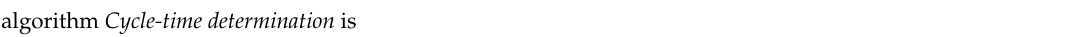
Algorithm 1. Cycle Time Minimization Algorithm. algorithm Cycle-time determination